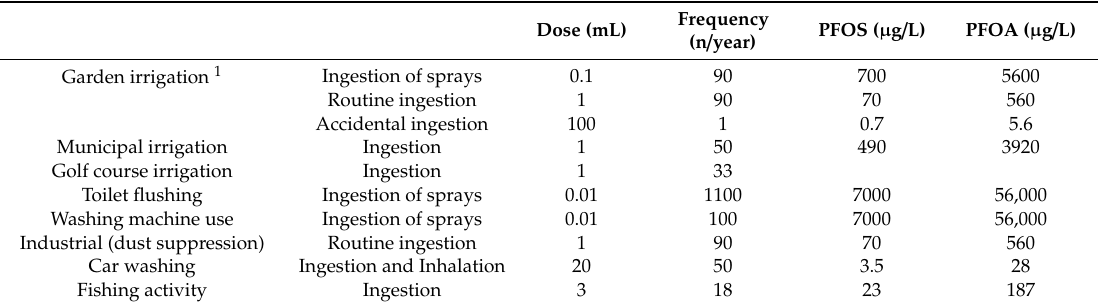
Table 6. Selected MAR recovered water uses, PFOS, and PFOA concentrations that meet Australian tolerable daily intake values for water